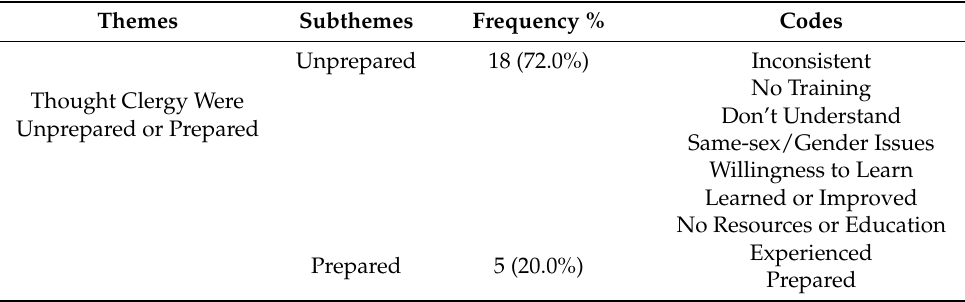
Table 3. Perceptions of meetings with clergy: themes, frequencies, and